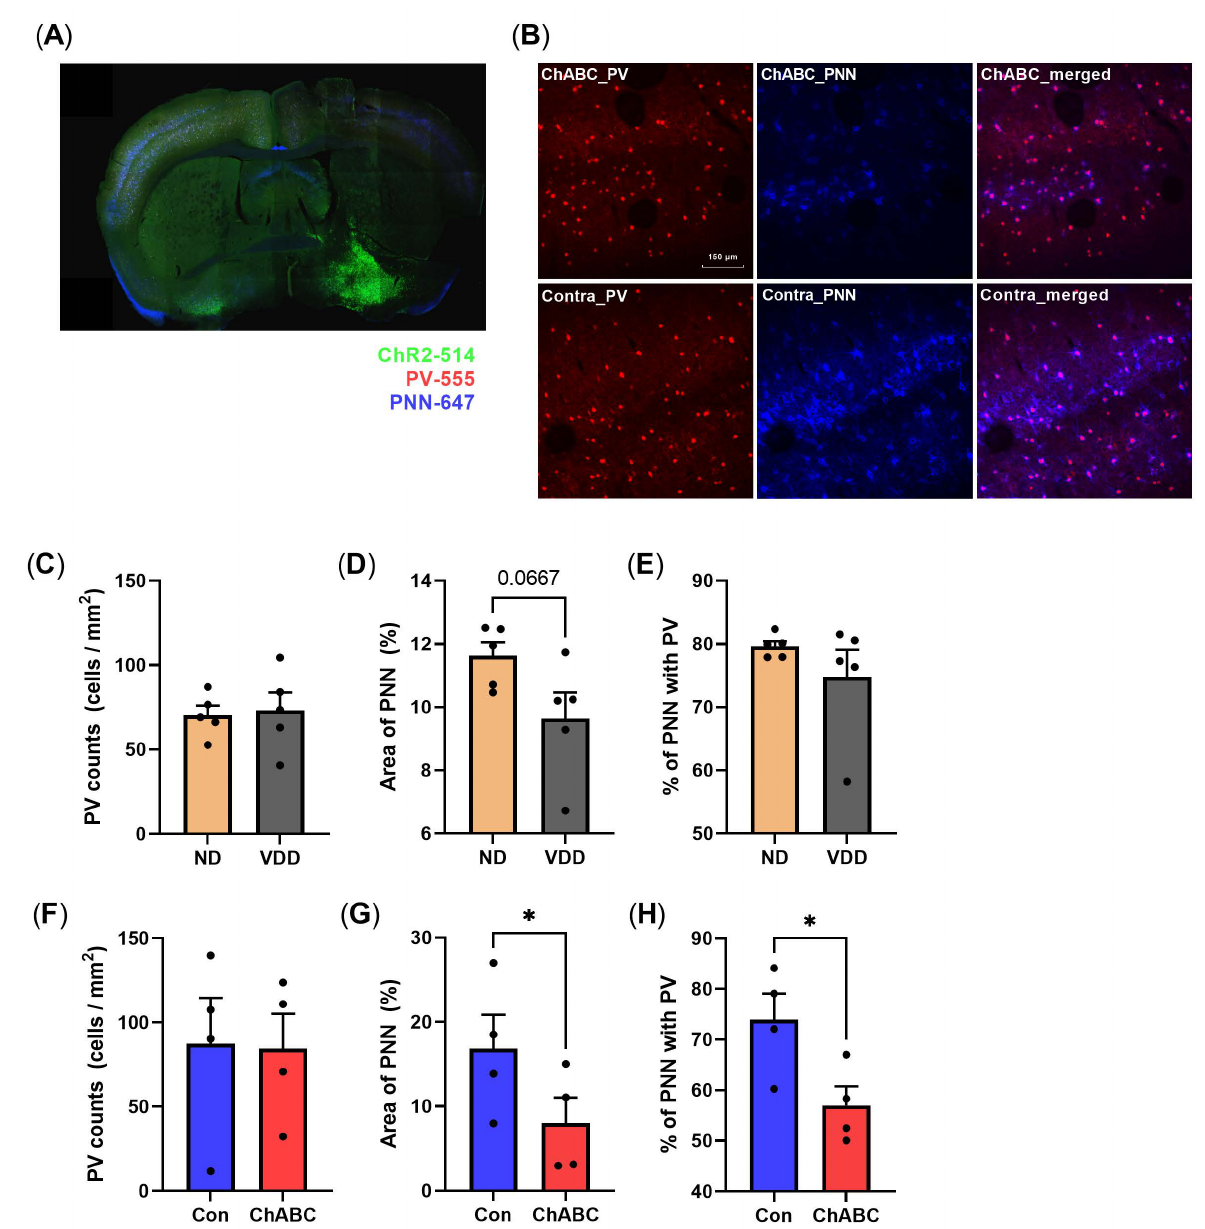
Figure 8. Immunohistochemistry for the quantification of PV and PNN. ( A ) Representative 10 × confocal image for a whole-brain section of 20 week old vitamin D-deficient mouse. ChR2 expression in the left hemisphere basal forebrain (Green), parvalbumin (Red) and PNN (Blue) are expressed in the brain section. ( B ) Representative 30 × confocal images of a ChABC-injected mouse. ChABC-injected left hemisphere (upper) showed a reduction of PNN compared to the contralateral hemisphere (lower). ( C – H ) The number of PV neurons, area of PNN, and colocalization percent of PV and PNN among all PV neurons. ( C ) PV counts between the normal diet group and vitamin D-deficient diet group. ( D ) Comparison of the area of PNN expression between the normal diet group and vitamin D-deficient diet group. ( E ) Percent colocalization of PNN and PV among all PV neurons between the normal diet and vitamin D-deficient groups. ( F ) PV counts between ipsilateral (ChABC) and contralateral (Con) sites of the ChABC-injected group. ( G ) Area of PNN expression between the ipsilateral and contralateral sites of the ChABC-injected group. ( H ) Percent colocalization of PNN and PV among all PV neurons between the ipsilateral and contralateral sites of the ChABC-injected group. Data are expressed as mean ± SEM. * p < 0.05 by the Student’s t